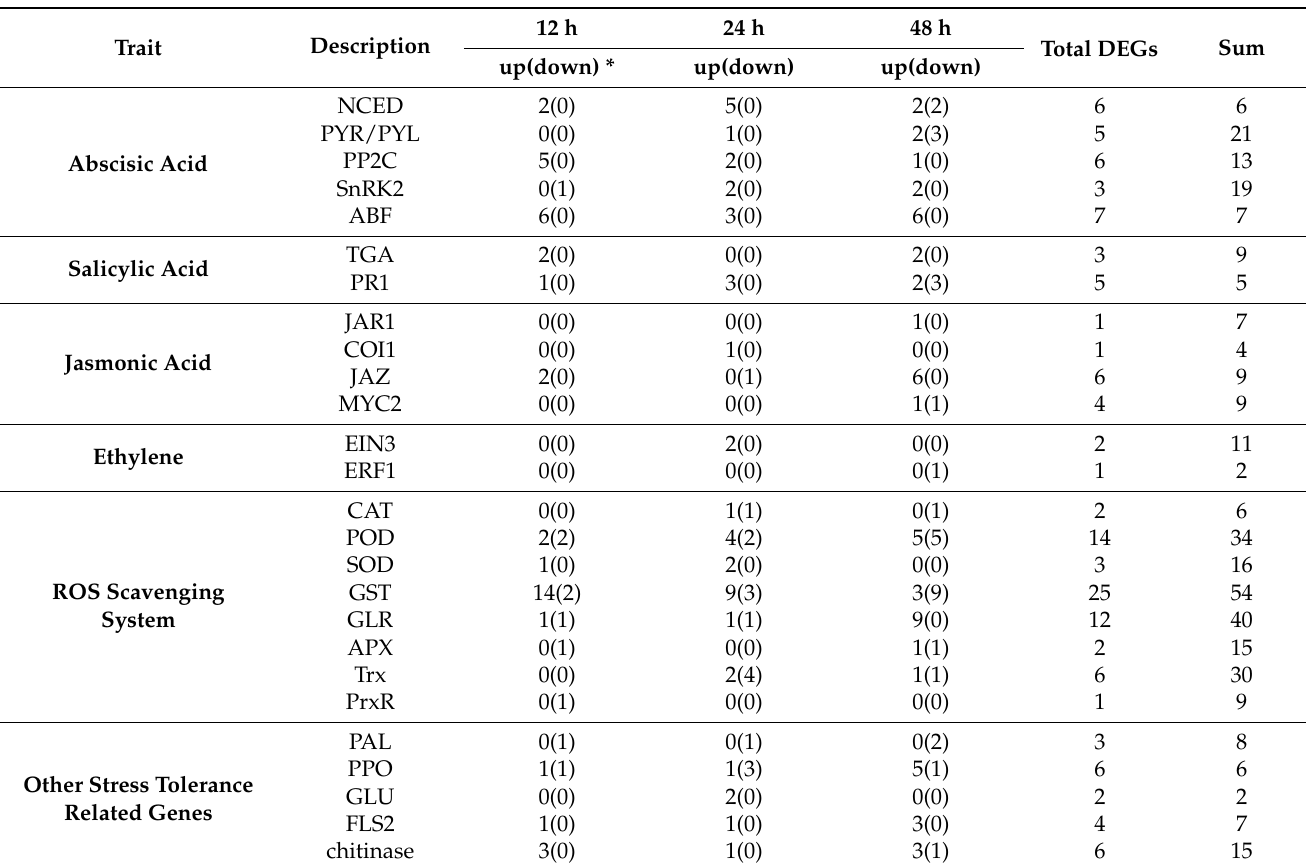
Table 1. Differential expression of the genes related to ABA, jasmonic acid, salicylic acid, and ethylene signaling pathways, reactive oxygen species scavenging, and other stress tolerance related genes in the tobacco transcriptome. Trait